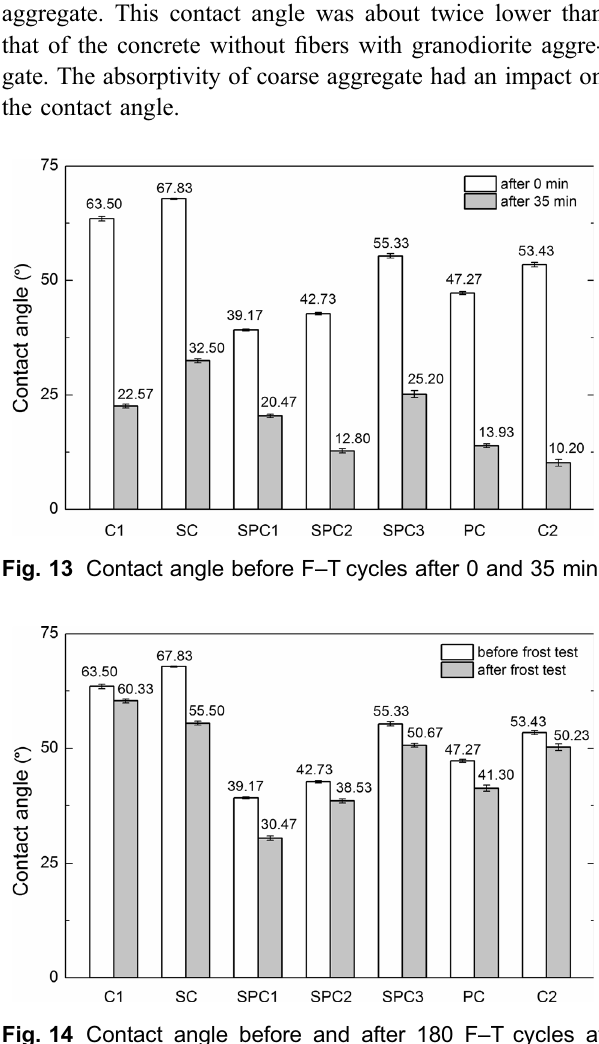
Fig. 14 Contact angle before and after 180 F–T cycles at beginning of drop